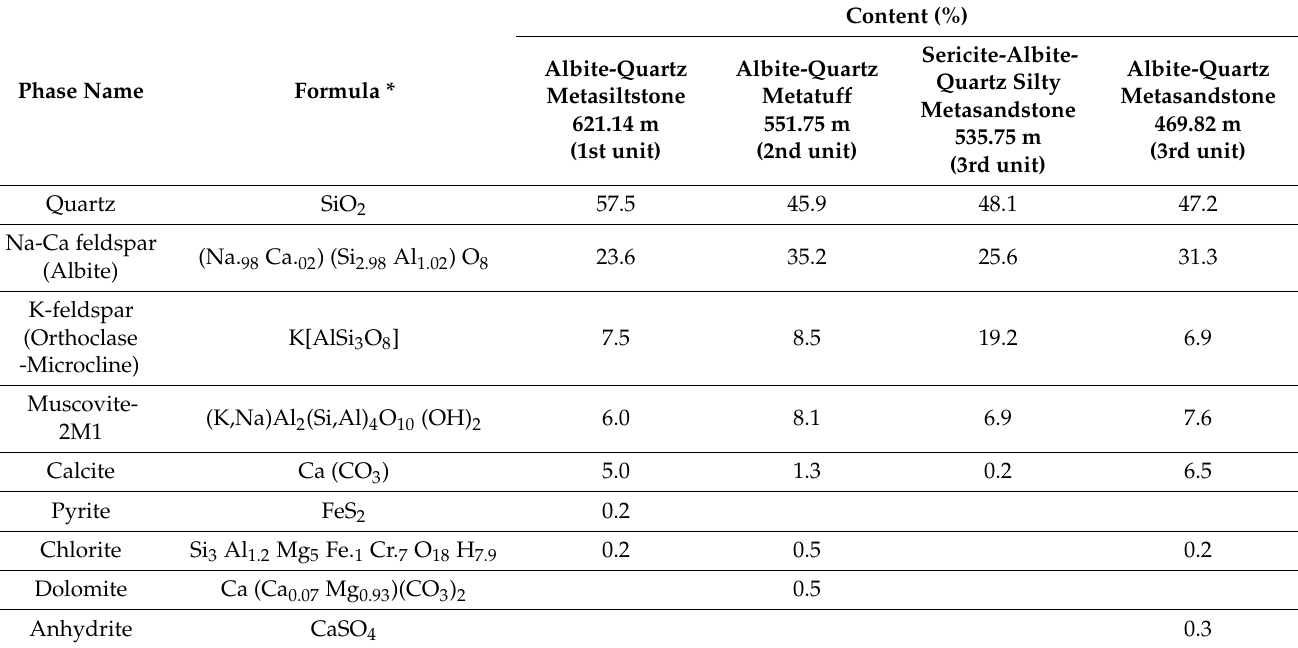
Table 2. The result of Quantitative XRD-analysis of Four Basement Rock Samples (bulk